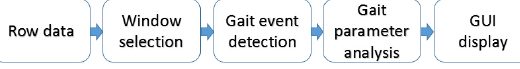
Figure 3: System